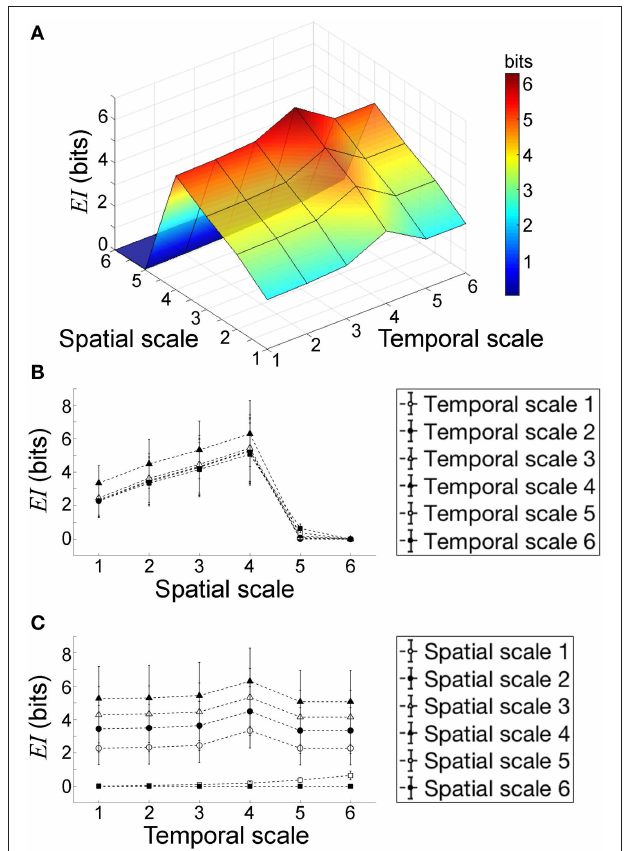
FIGURE 7 | Effective information of the system in aggregate data sets. (A) Overview. Each point indicates the mean effective information EI ( X → Y ) of 1,000 data sets at each spatiotemporal scale. EI ( X → Y ) reaches the global maximum at spatial scale = temporal scale = 4. (B) Effective information vs. spatial scale. (C) Effective information vs. temporal. Each point indicates the mean of EI of 1,000 data sets at each spatiotemporal scale.